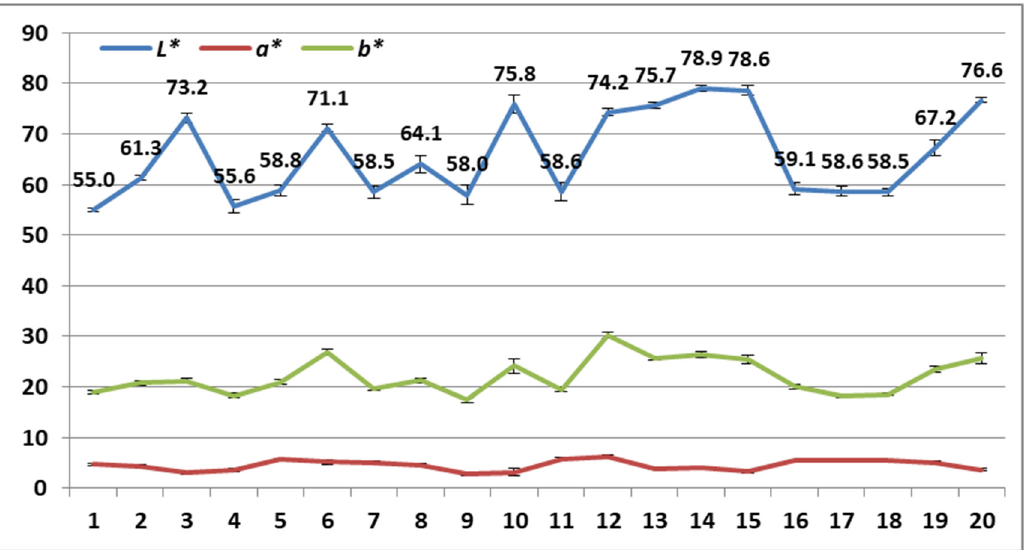
Figure 14. Mean values of surface colour coordinates L *, a * and b * for the examined brands of pel- lets